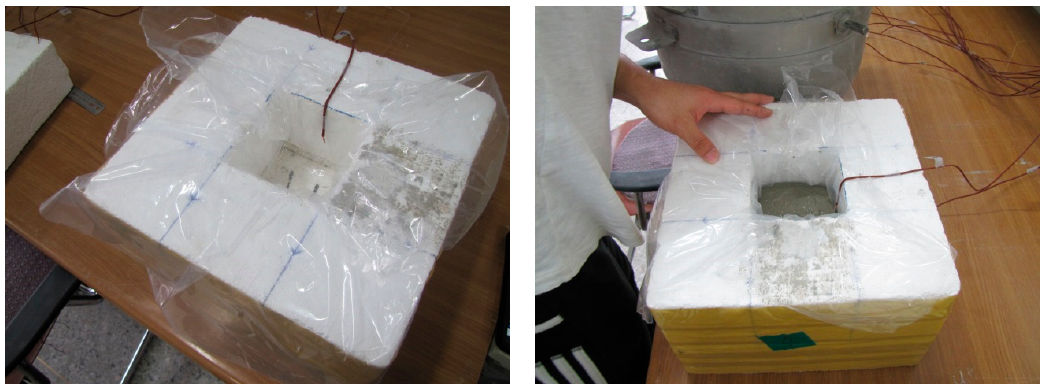
Figure 2. Set-up for semi-adiabatic temperature rise testing.